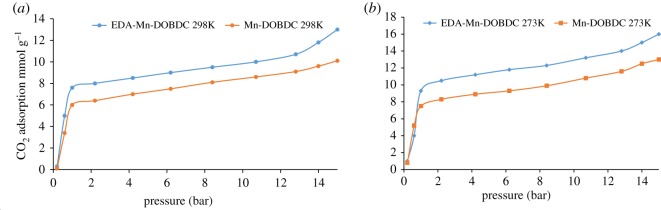
CO2 adsorption isotherms in mmol g−1 for Mn-DOBDC and EDA-Mn-DOBDC at 273 K (a) and 298 K (b).